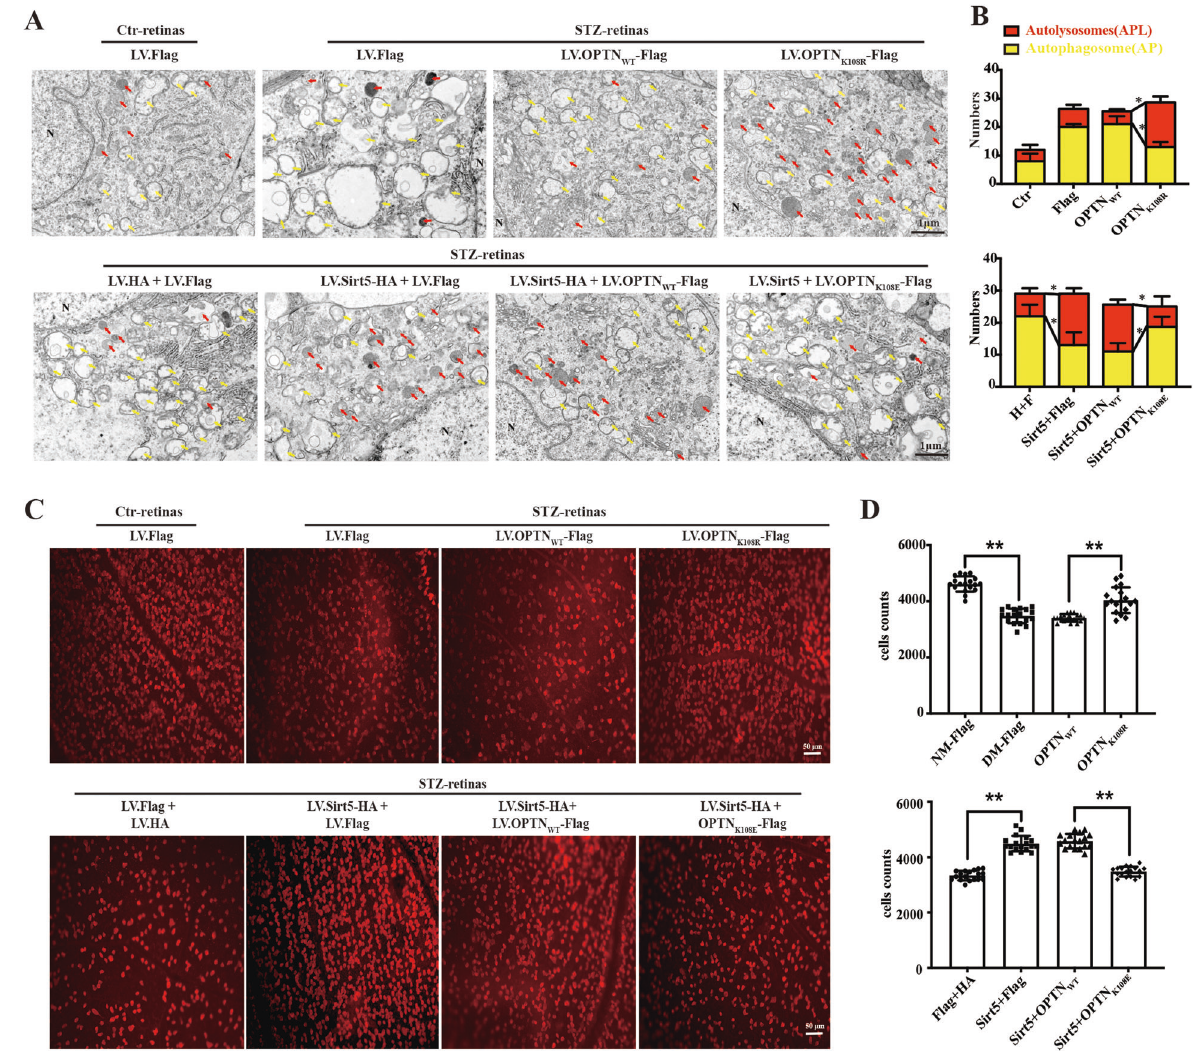
Fig. 6 The Sirt5-OPTN K108 su axis induces the formation of autolysosomes and alleviates RGCs loss in STZ-induced diabetic rats. A , B TEM images of RGCs from eyes injected with the indicated lentivirus. Note the accumulation of AP in diabetic retinas. The presence of Sirt5 and the K108R mutant improved APL degradation. AP is indicated by yellow arrows, and APL is indicated by red arrows. Representative images ( A ) and quantitative data ( B ) for each group are provided. Scale bars: 1 µm. C , D Quanti fi cation of RGCs in rat retinal whole mounts. The phenotypic marker RBPMS labeled the soma of RGCs. Representative images ( C ) and quantitative data ( D ) of RBPMS + RGCs subjected to eye injection of the indicated lentivirus. The data are shown as the mean ± SD ( n = 6). * p < 0.05. ** p < 0.01. TEM transmission electron microscopy, AP autophagosome, APL autophagolysosome, NM normal glucose, DM diabetes